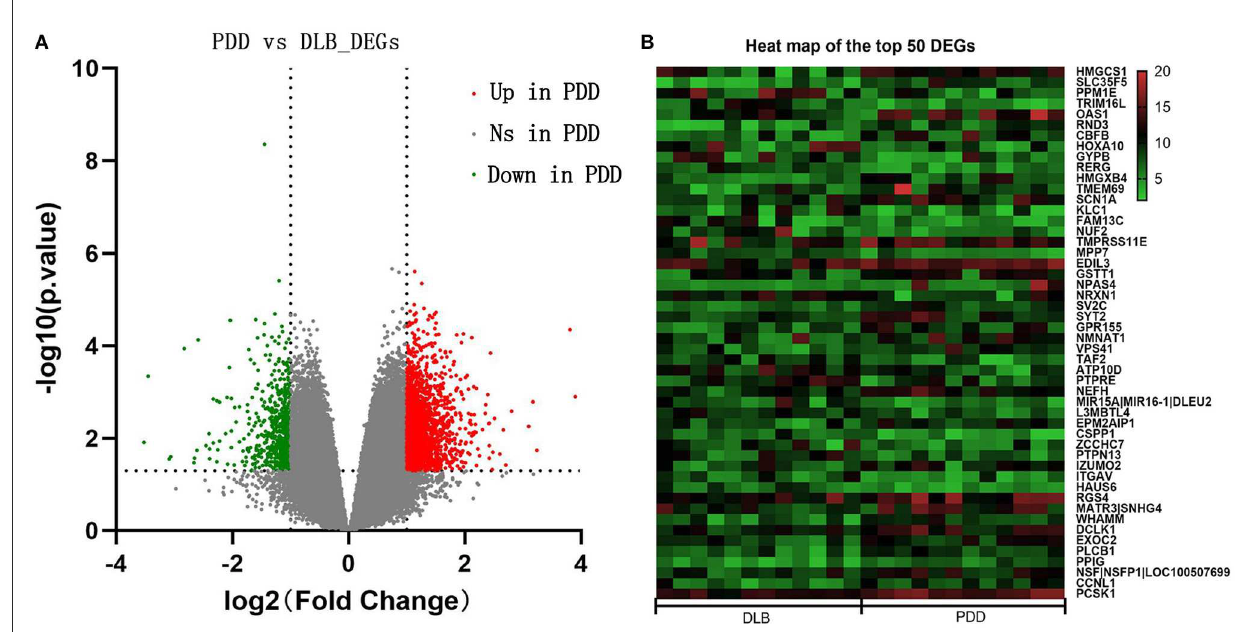
FIGURE1 (A) Volcano maps of all differentially expressed genes (DEGs) between Parkinson’s disease dementia (PDD) and Dementia with Lewy bodies (DLB). The red color represents upregulated genes, and the green color represents downregulated genes in PDD; gray represents genes that are not differentially expressed. The dashed horizontal and vertical axes indicate the log fold change absolute threshold of 1 and the P -value threshold of 0.05, respectively. (B) Heat map of the top 50 DEGs. The color gradient from green to red indicates gene regulation from downregulation to upregulation in PDD or DLB. Numbers 5–20 indicate gene expression